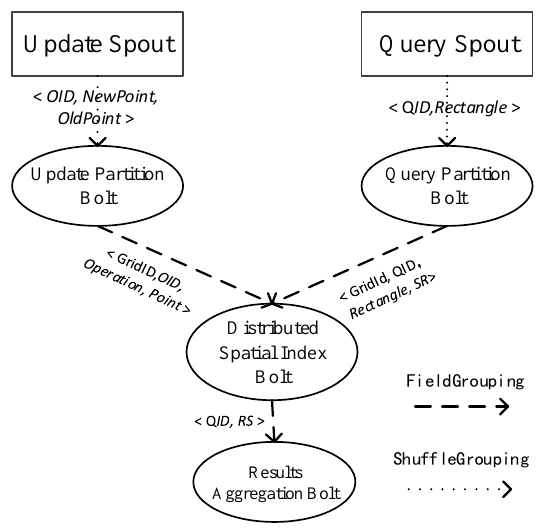
Figure 3. Storm topology for spatial joins.